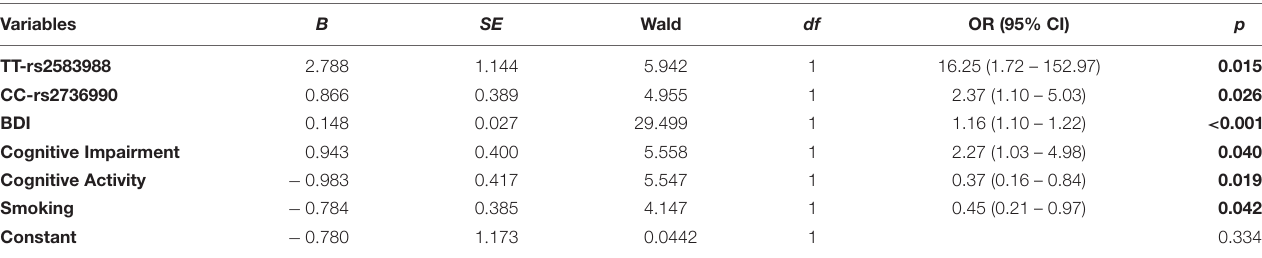
TABLE 6 | Binary logistic regression model for SNPs genotypes, clinical variables, and environmental factors predicting